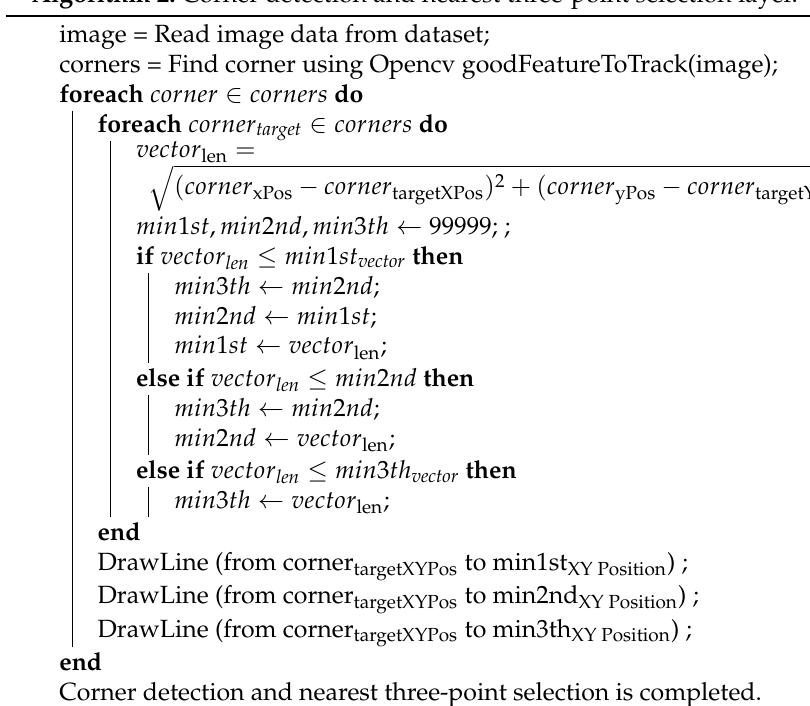
Algorithm 2: Corner detection and nearest three-point selection layer.